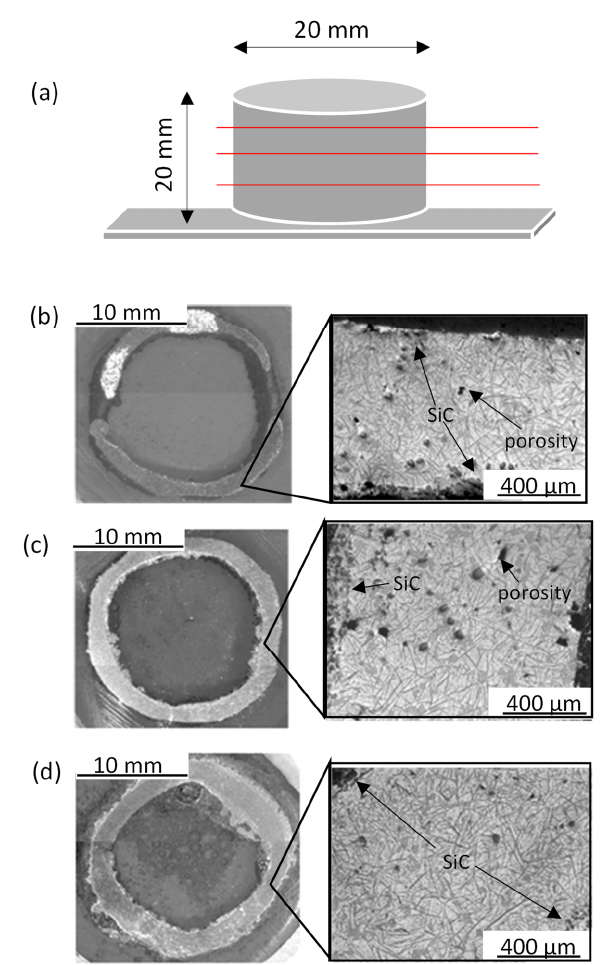
Figure 2. ( a ) Scheme of the cylinder morphology; ( b ) top of the sample cross-section; ( c ) middle of the sample cross-section; ( d ) bottom of the sample cross-section. sample cross-section; ( d ) bottom of the sample cross-section.